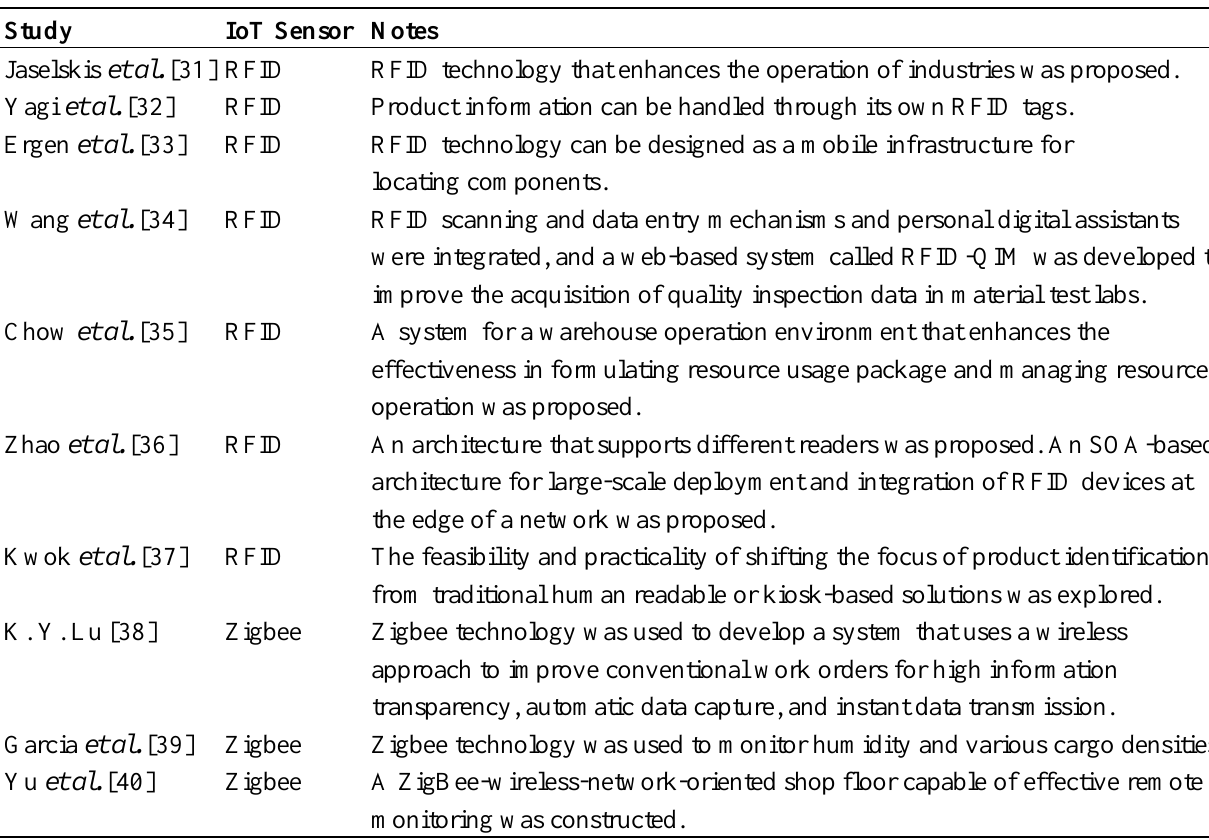
Table 3. Summary of IoT technology studies used in